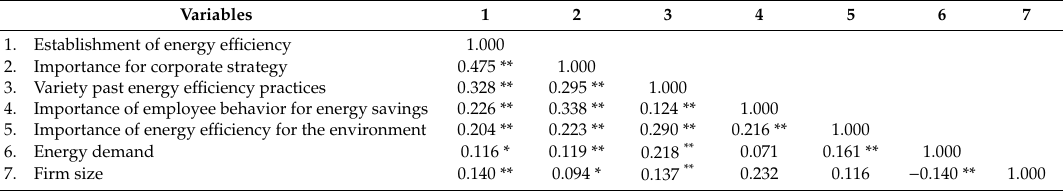
Figure 5. Establishment of energy e ffi ciency in the SMEs. Table 5. Factors correlating with the establishment of energy e ffi ciency within the